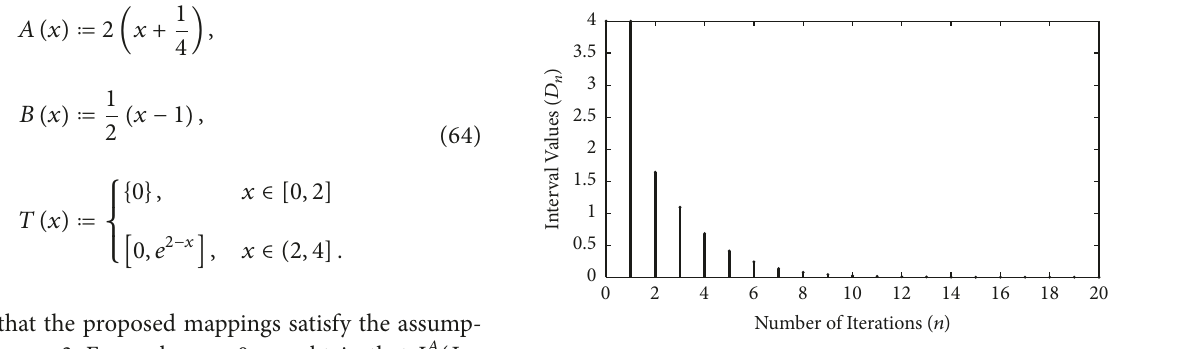
Figure 3: The behaviors of the set 𝐷 𝑛